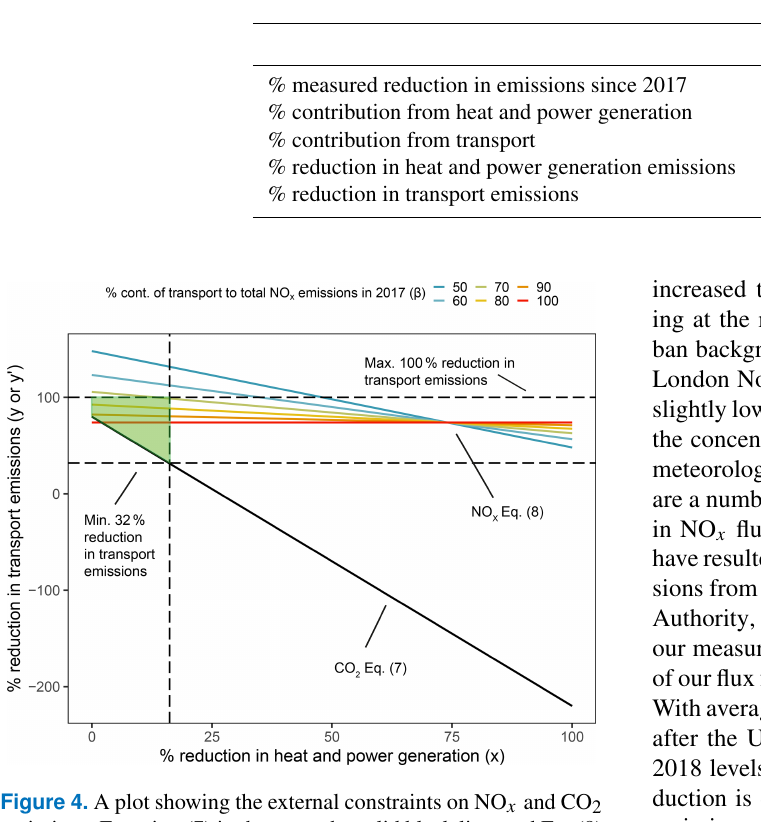
Table 1. A summary of the data used in the formation of simultaneous Eqs. (7) and (8).